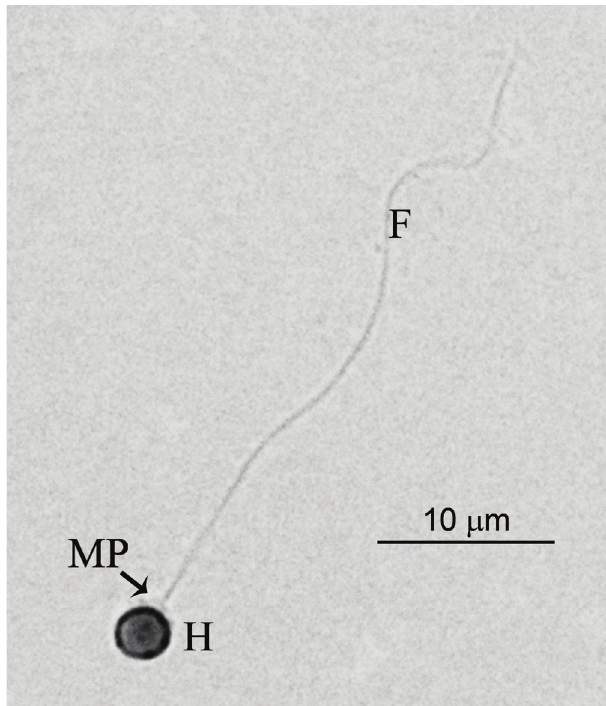
Fig. 1. Fresh pejerrey spermatozoa stained with eosin. H: Head; MP: Midpiece; F: Flagellum.